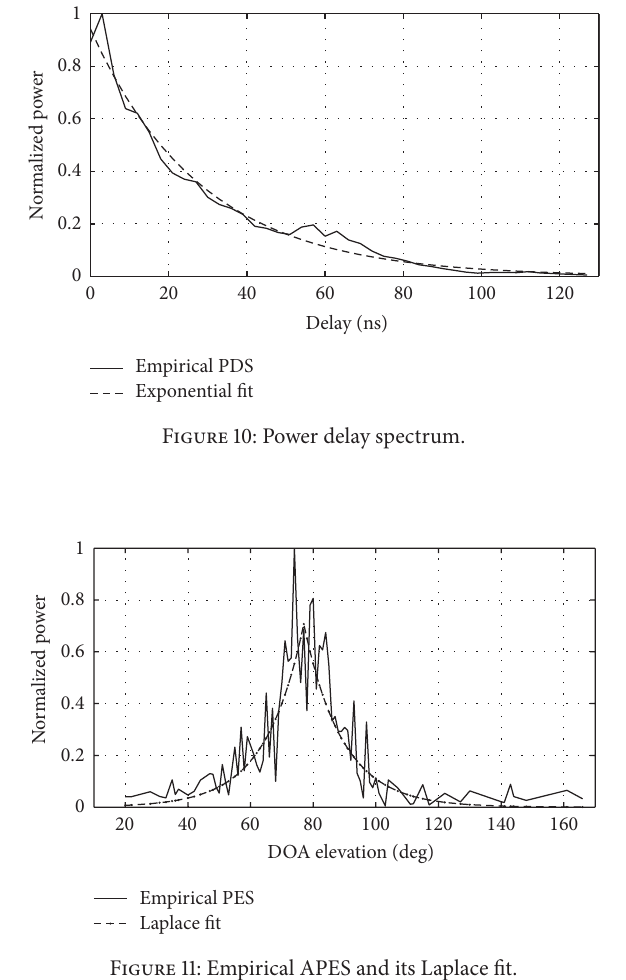
∘ and 17 ∘ , respectively. In (31), the factor 1/√2 is 𝜎 𝜃 𝑅𝑥 are 14 normalized constantly to satisfy